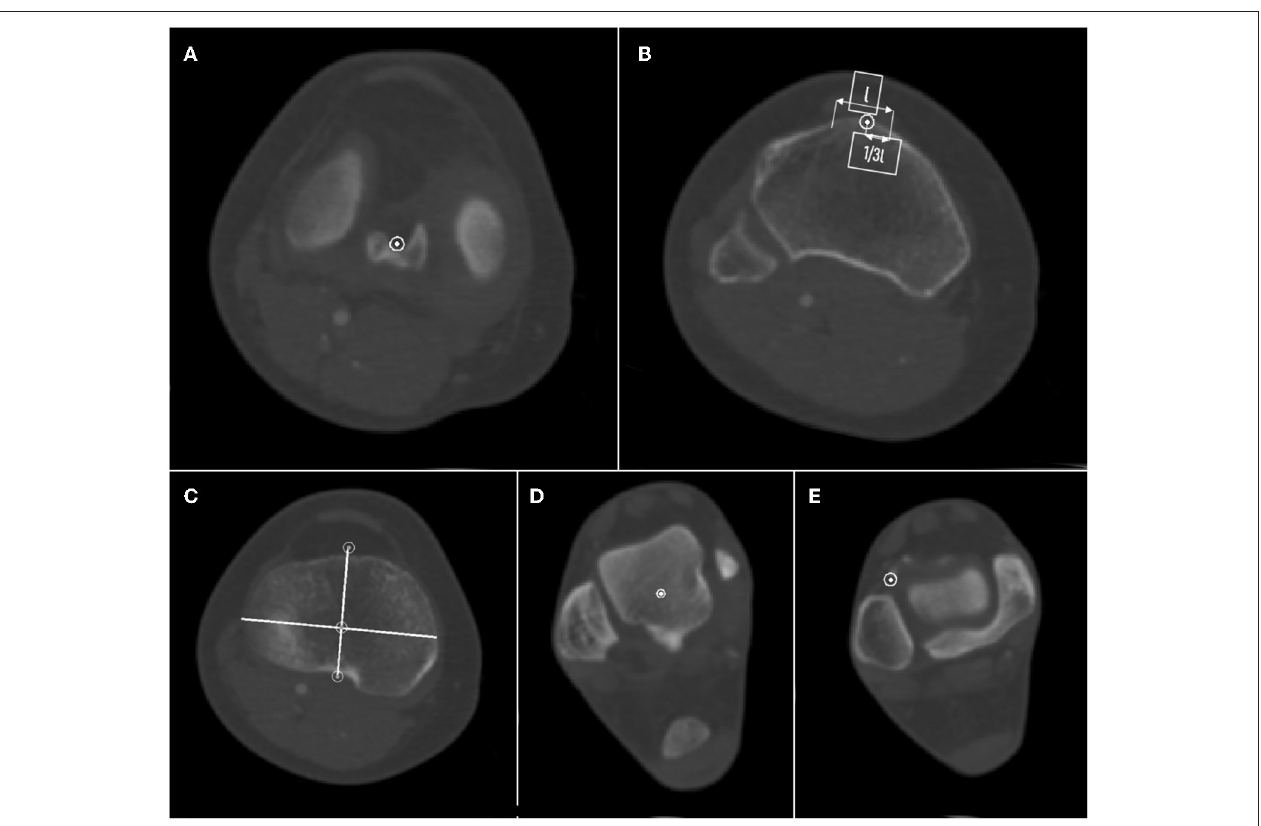
FIGURE 1 | Schematic diagram of tibia measurement. (A) Tibial plateau center. (B) The medial third of the tibial tuberosity. (C) AP axis and transverse diameter of tibial plateau. (D) Ankle center. (E) Lateral point of articular surface of distal tibia (LADT). The arrow means tibial tuberosity width.